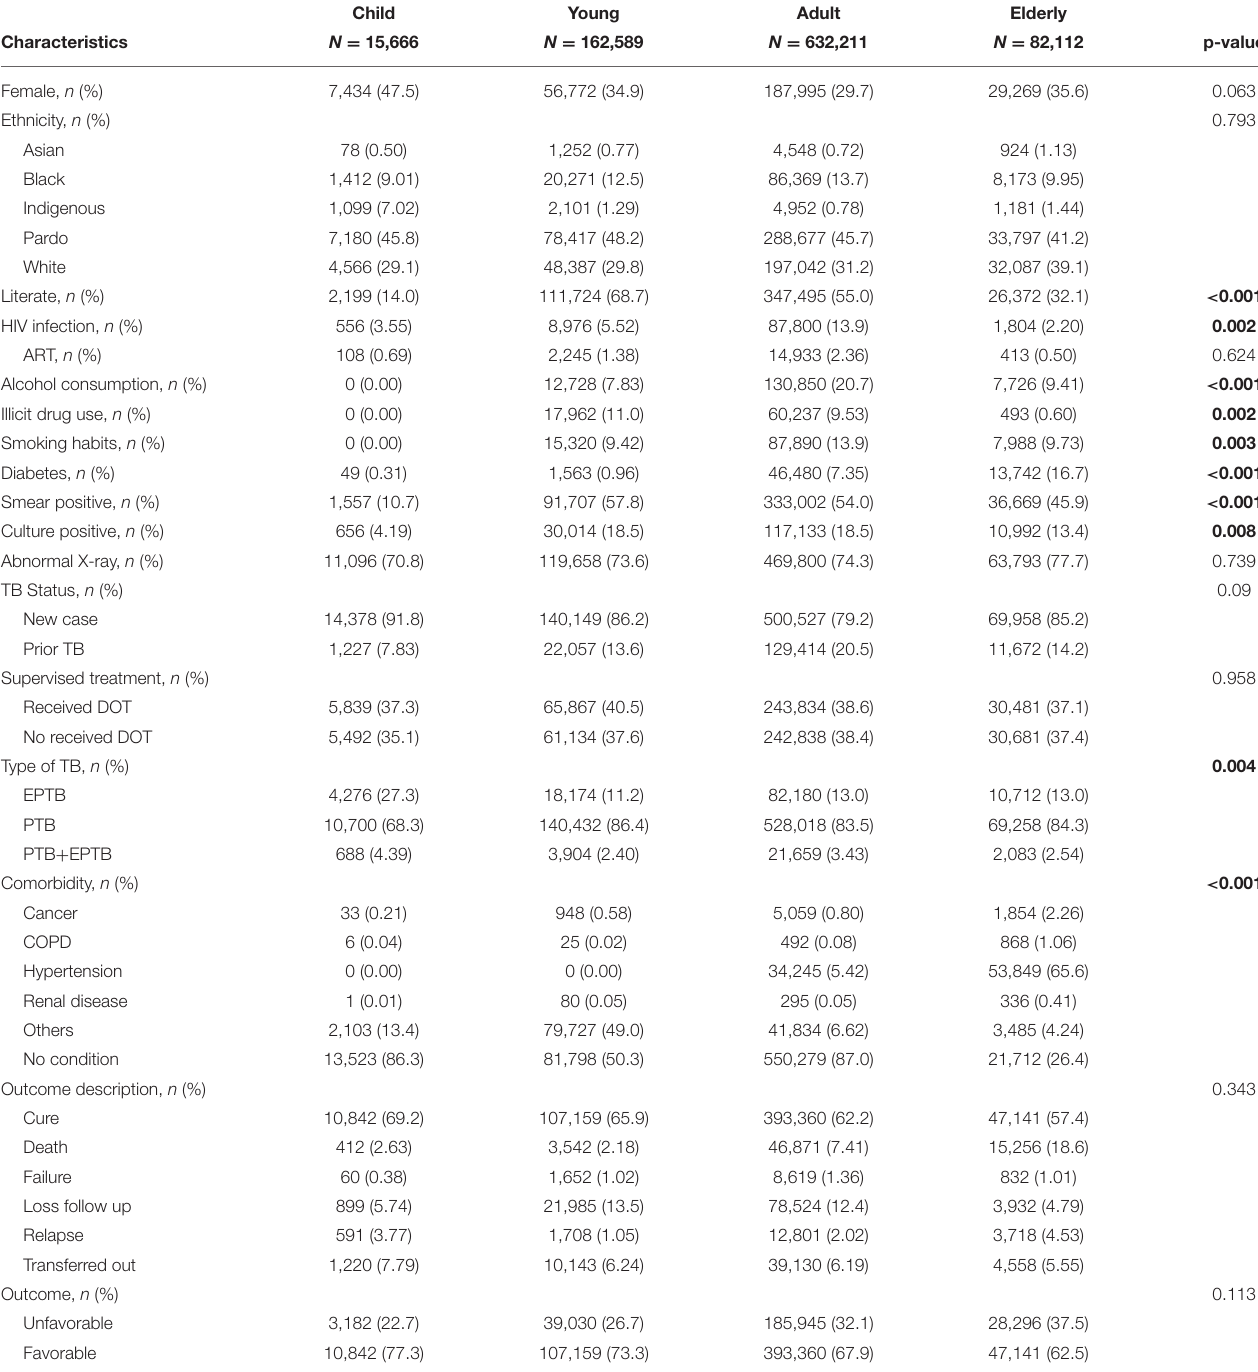
TABLE 2 | Population characteristics by age categories. Child Young Adult